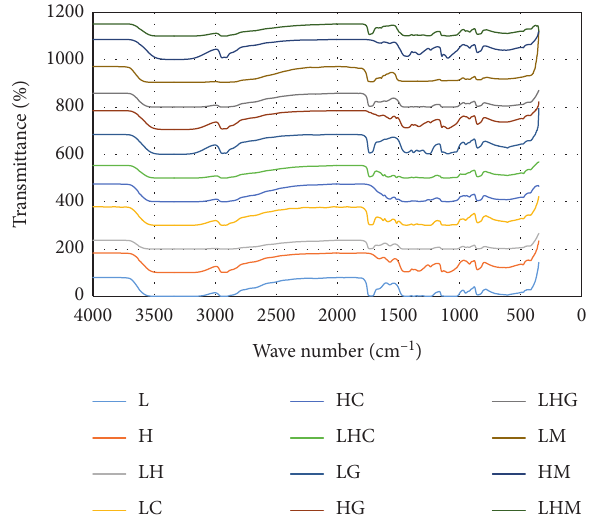
Figure 23: FTIR spectra of drug-loaded polymeric